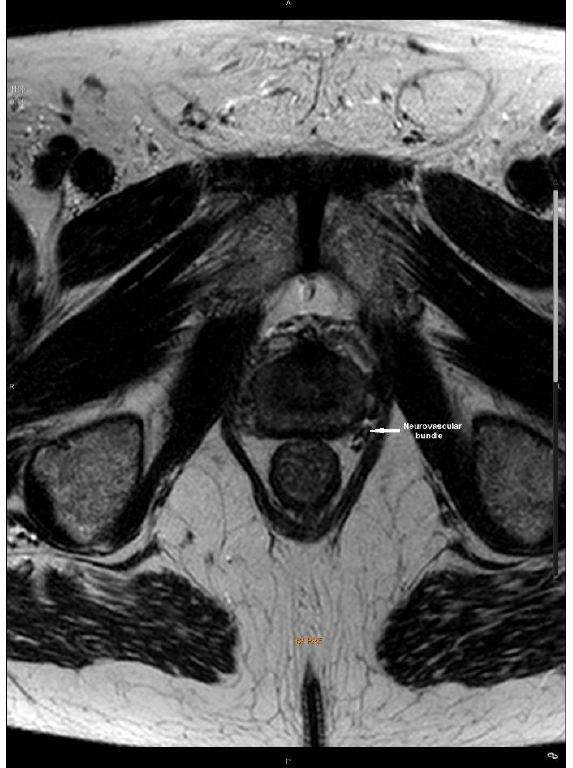
Figure 1. Magnetic resonance image identifying the neurovascular bundle.